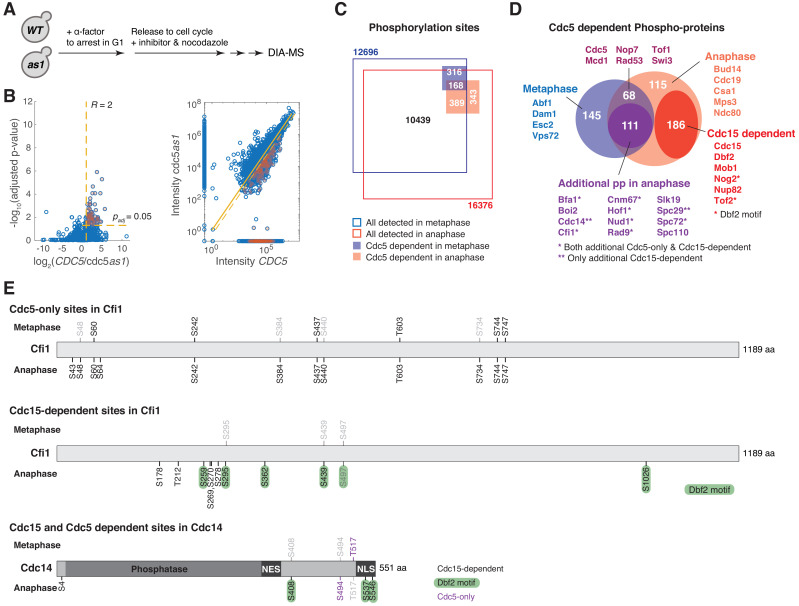
Identification of CDC5-dependent phosphorylation sites in metaphase.(A) Overview of the sample preparation for phosphoproteomic analysis to map CDC5-dependent phosphorylation sites in metaphase. Same procedures were followed as in Figure 5—figure supplement 1A except that following release of cells from the G1 arrest, cells were resuspended in medium containing the inhibitor CMK (5 μM) and nocodazole (15 μg/ml). (B) Volcano plot and correlation of peptide intensities with and without inhibition of Cdc5 (cdc5-as1 or WT) in metaphase. Yellow dashed lines indicate the cutoff (R > 2 and padj<0.05, or detected in at least four out of six replicates in WT sample but missing in cdc5as1 sample) used to identify peptides whose phosphorylation depends on CDC5 as marked with red shaded dots. (C and D) Summary and comparison of phosphorylation sites (C) and phospho-proteins (D) detected in metaphase and anaphase. (E) CDC5-only and CDC15-dependent sites in Cfi1/Net1 and Cdc14 mapped in metaphase and anaphase. Light gray sites in metaphase/anaphase represent phosphorylation sites that were detected but were not determined as CDC5-dependent.